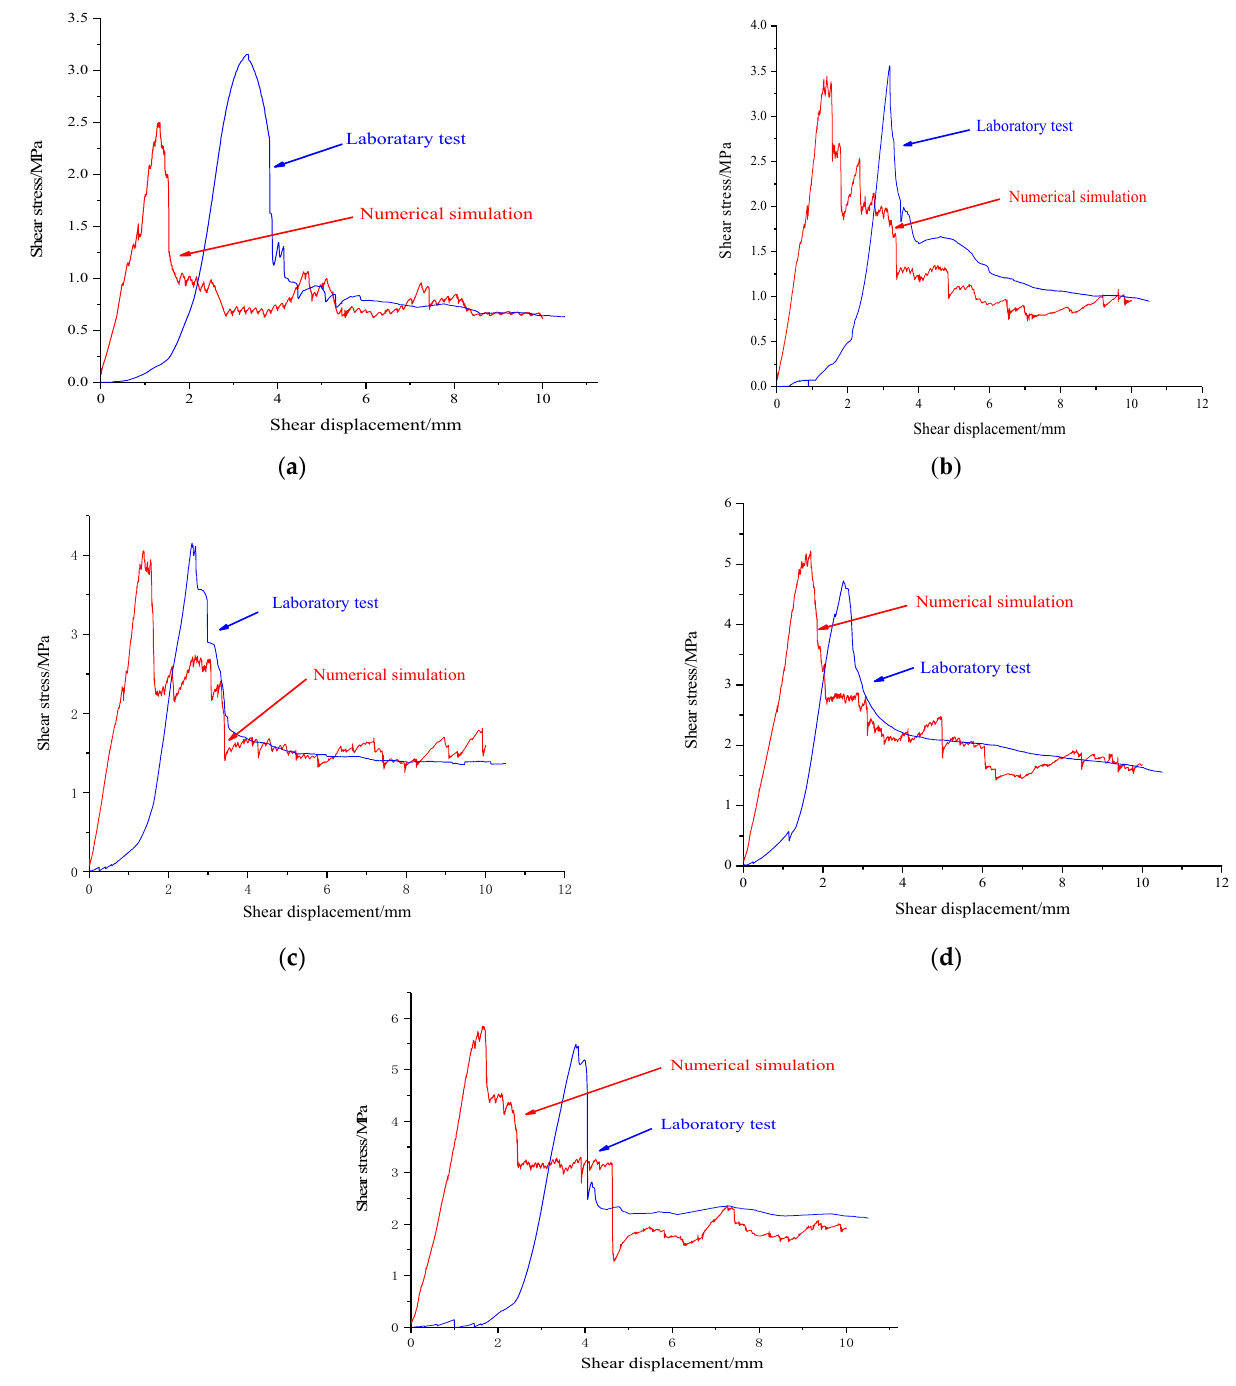
Figure 3. Numerical simulation results and laboratory testing results [39] with different normal stress of serrated structural plane. ( a ) Normal stress = 0.4 MPa. ( b ) Normal stress = 0.8 MPa. ( c ) Normal stress = 1.2 MPa. ( d ) Normal stress = 1.6 MPa. ( e ) Normal stress = 2.0 MPa.